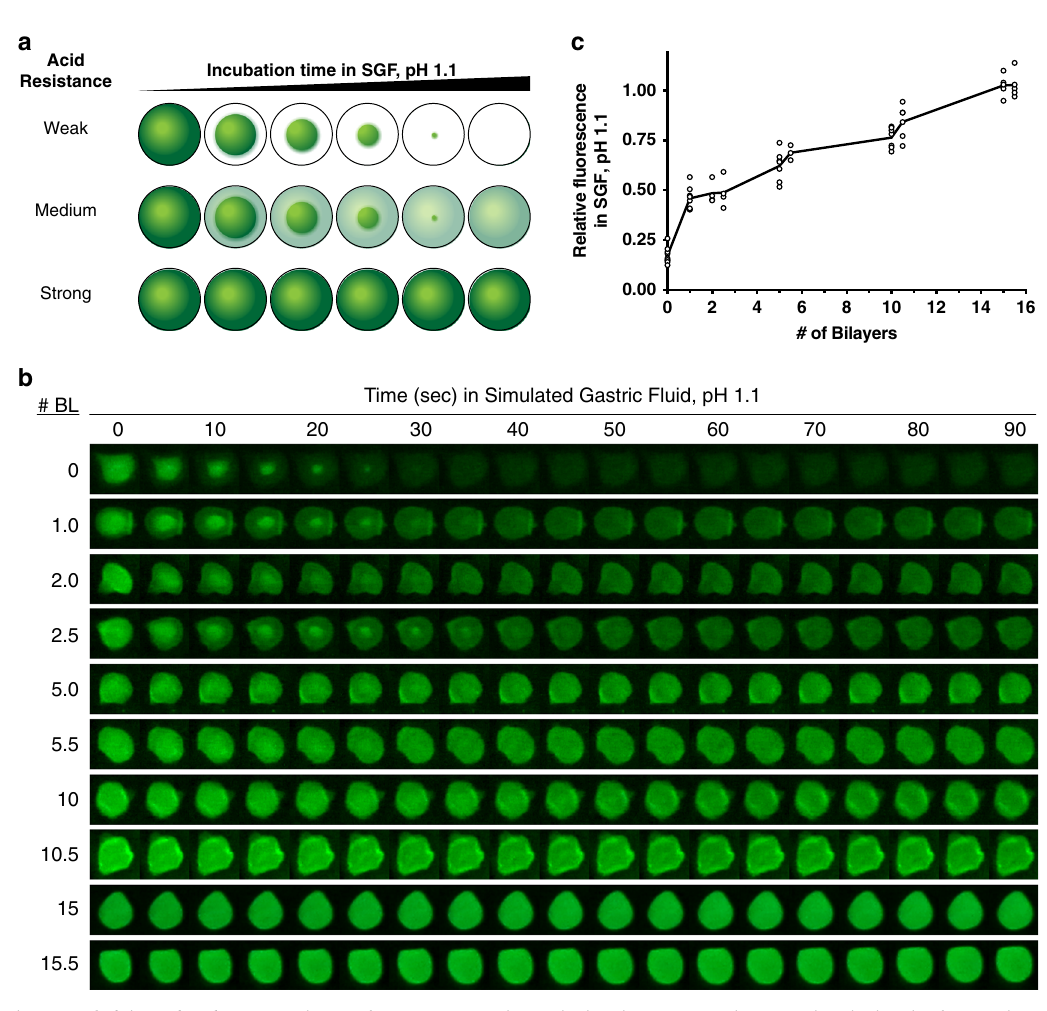
Fig. 4 Acid resistance of alginate beads. Encapsulation of a pH-sensitive dye in the beads can gauge the pH within the beads after incubation in simulated gastric fl uid (SGF) by a large or small loss in fl uorescence indicating beads that have been constructed with weak, medium, or strong acid resistance ( a ). By tracking the fl uorescence behavior of representative beads, non-coated (0-BL) and coated (up to 15.5-BL) alginate beads show distinct differences in acid resistance, which is repeatable across each bead analyzed in the following panel ( b ). The normalized change in fl uorescence after incubation in SGF pH 1.1 for 90 s shows a relationship with the number of bilayers deposited with symbols representing individual beads (9, 8, 4, 4, 7, 3, 7, 6, 5, and 5 beads for 0, 1, 2, 2.5, 5, 5.5, 10, 10.5, 15, and 15.5 bilayers, respectively) and the line indicating the mean ( c ). Source data are provided as a Source Data fi